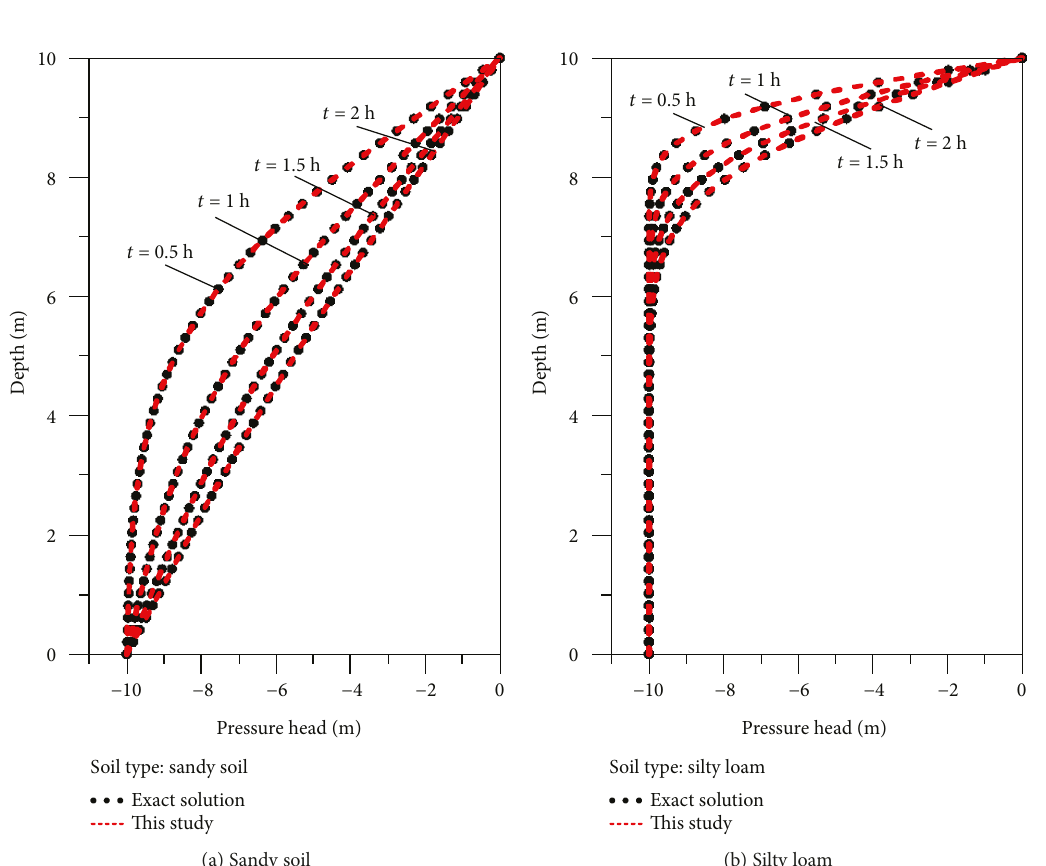
Figure 7: Result comparison with the exact solution for sandy soil and silty